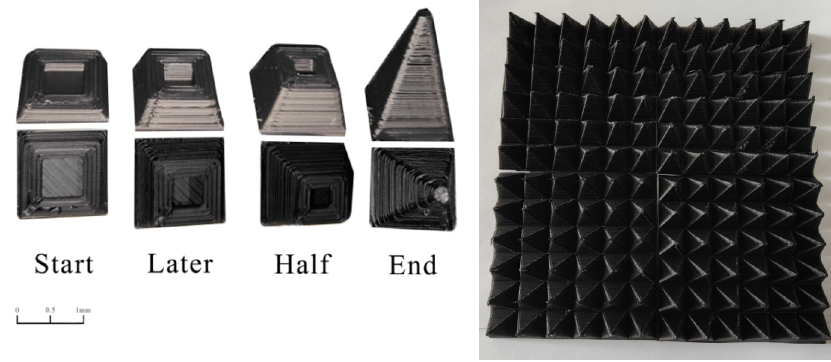
Figure 17. Printed pyramid structural absorber.